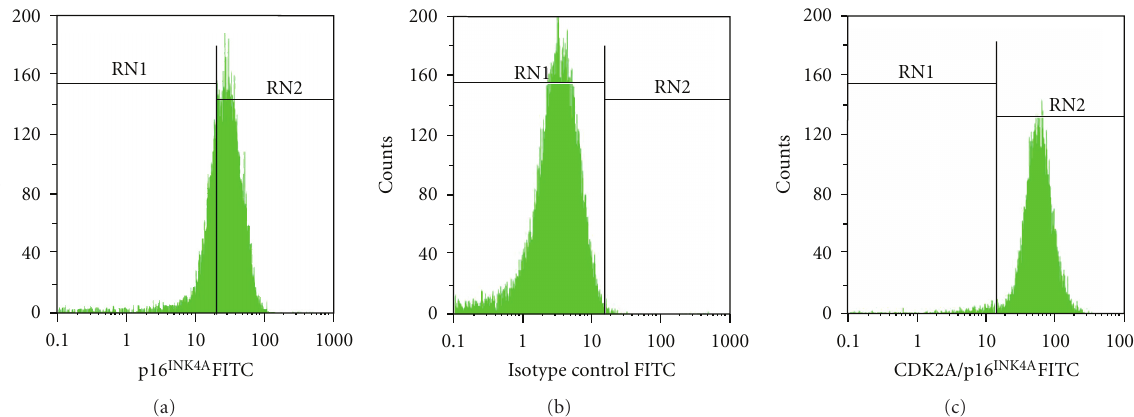
Figure 5: Flow-cytometry analysis of HeLa cells immunostained with the MAbs: (a) clone 9F12 (IgG1 subtype) raised against pseudotype VLPs harbouring the p16 INK4A protein; (b) negative control, irrelevant Mab of IgG1 subtype; (c) positive control, commercial MAb against p16INK4A protein